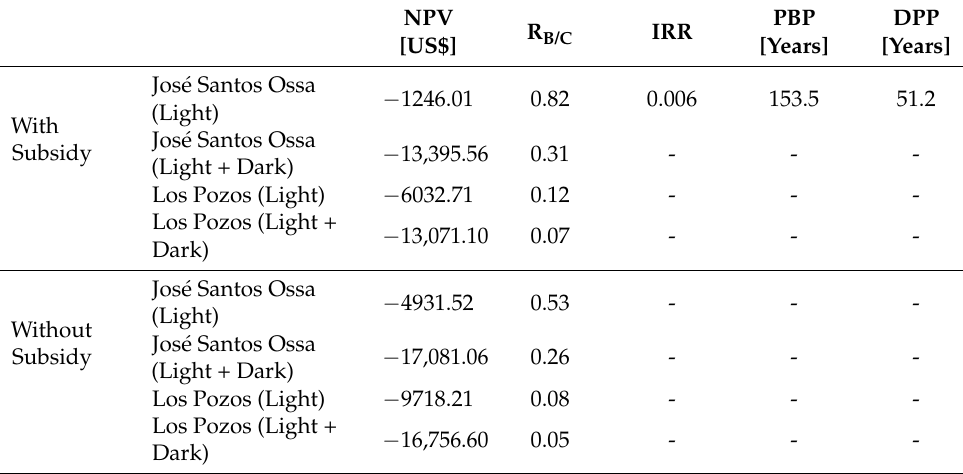
Table 5. Economic indicators of